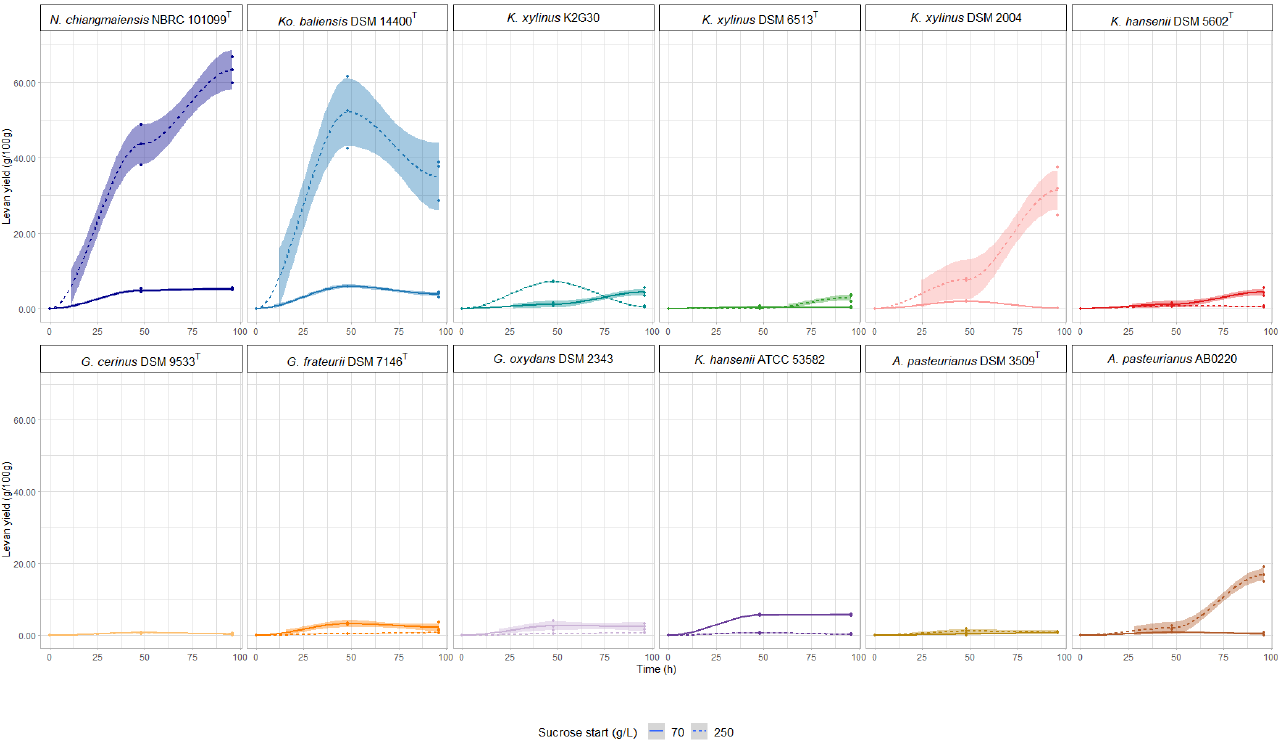
Figure 1. Change in levan production based on sucrose concentration. Values are represented with a confidence interval (CI) of 95%.